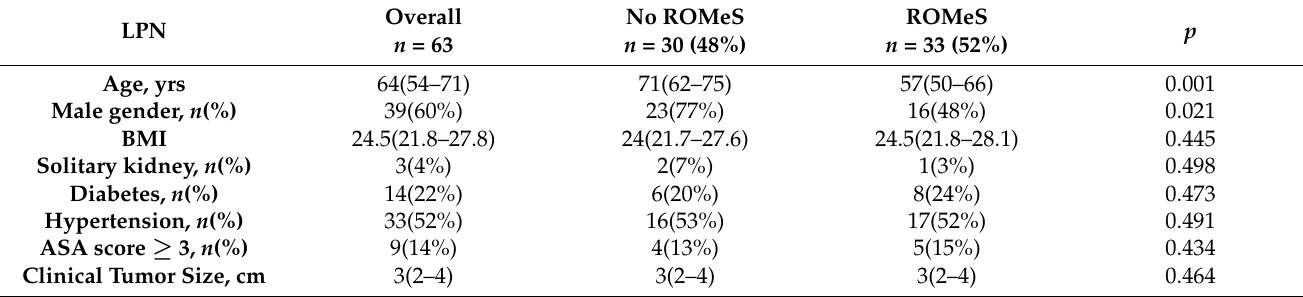
Table 1. Patients’ characteristics at baseline.